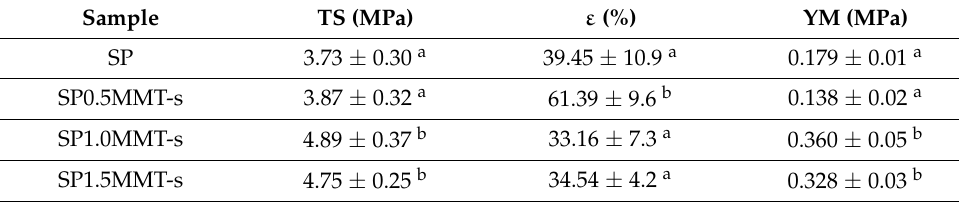
Table 4. Mechanical properties of SP films reinforced with